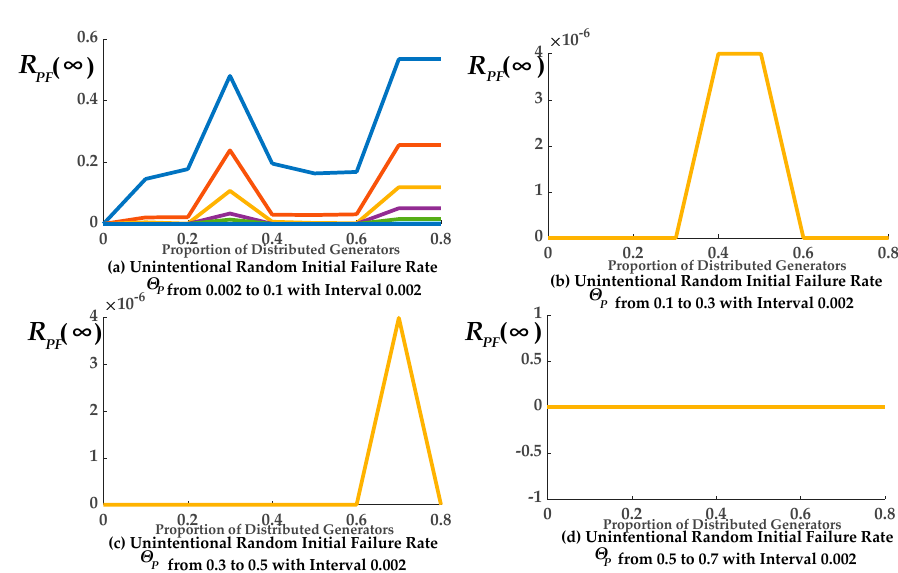
Figure 5. The final expected proportion of normal operational nodes in the power network (PN) after the CCF stops ( R PF ( ∞ )) of different distributed generators proportions in the PN with Erdos–Renyi (ER) topological structure.